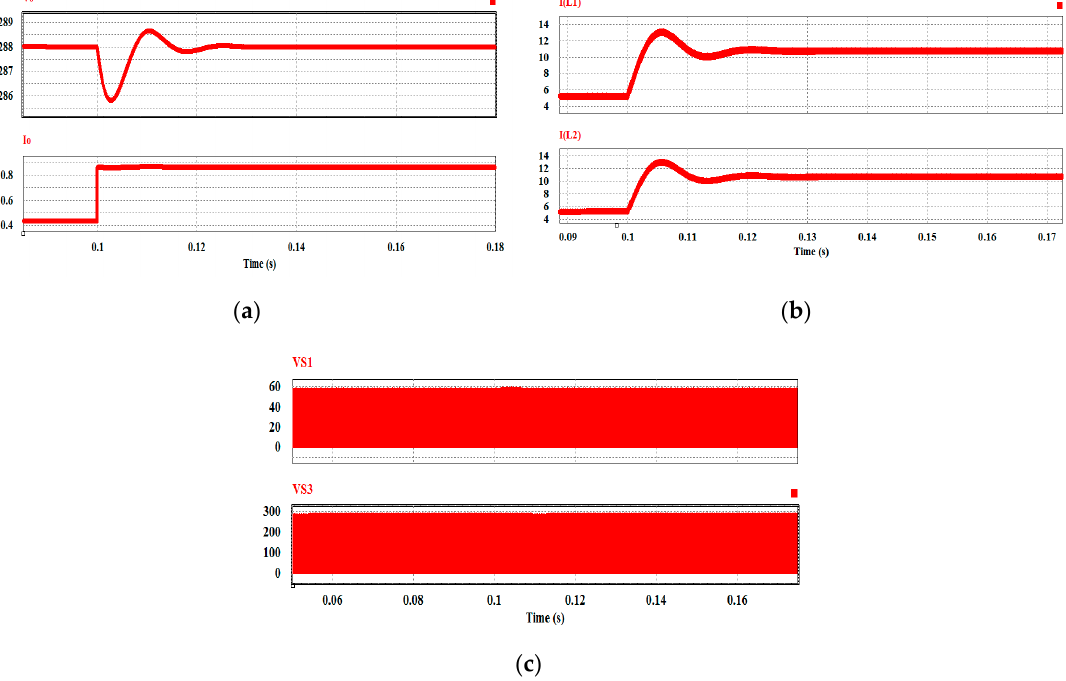
Figure 13. Simulation waveforms for V in = 12 V with step change in load from 50% load to rated full load; ( a ) V o is output voltage, I o is output current, ( b ) I L 1 and I L 2 are input inductor currents, and ( c ) V s 1 and V s 3 are voltages across the switches S 1 and S 3 , respectively.